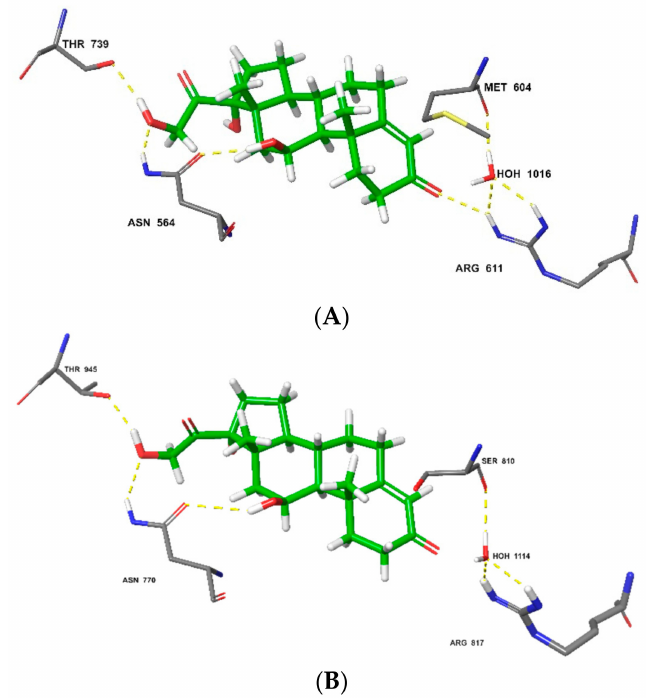
Figure 9. Molecular interactions of HCT and glucocorticoid receptor with ( A ) glide-docking score: − 13.026 kcal/mol; and mineralocorticoid receptor with ( B ) glide docking score: − 11.084